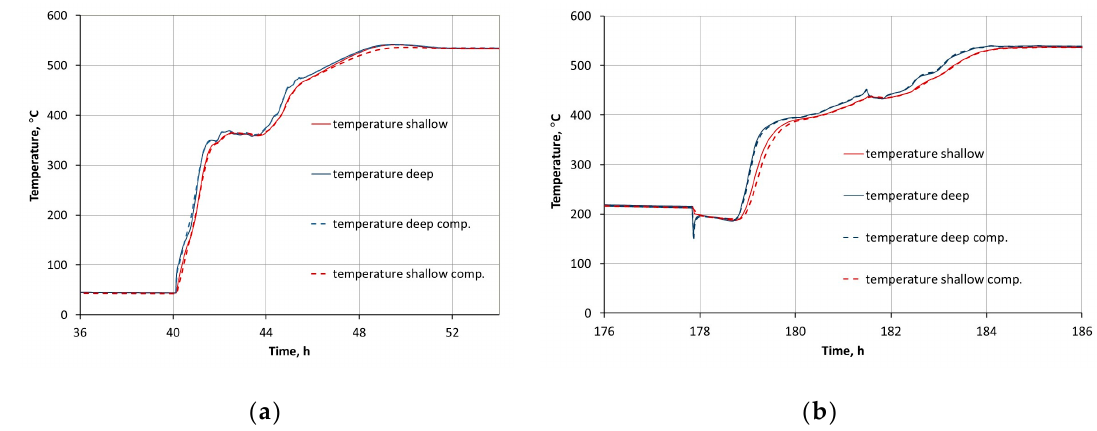
Figure 13. Comparisons of the temperature changes computed by the FEM with the changes measured over time at selected points of the junction; the calculations were made for α determined on the basis of the Nu number with a local modification, 3000 W/m 2 K: ( a ) a cold startup; ( b ) a hot startup.